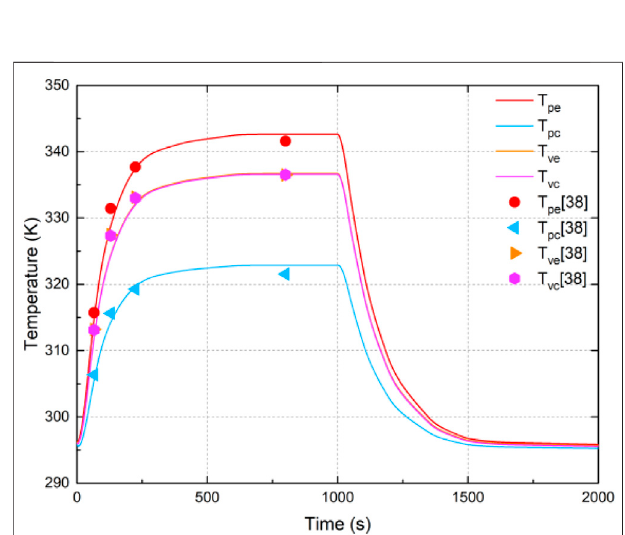
FIGURE 10 | Comparison with experimental results.